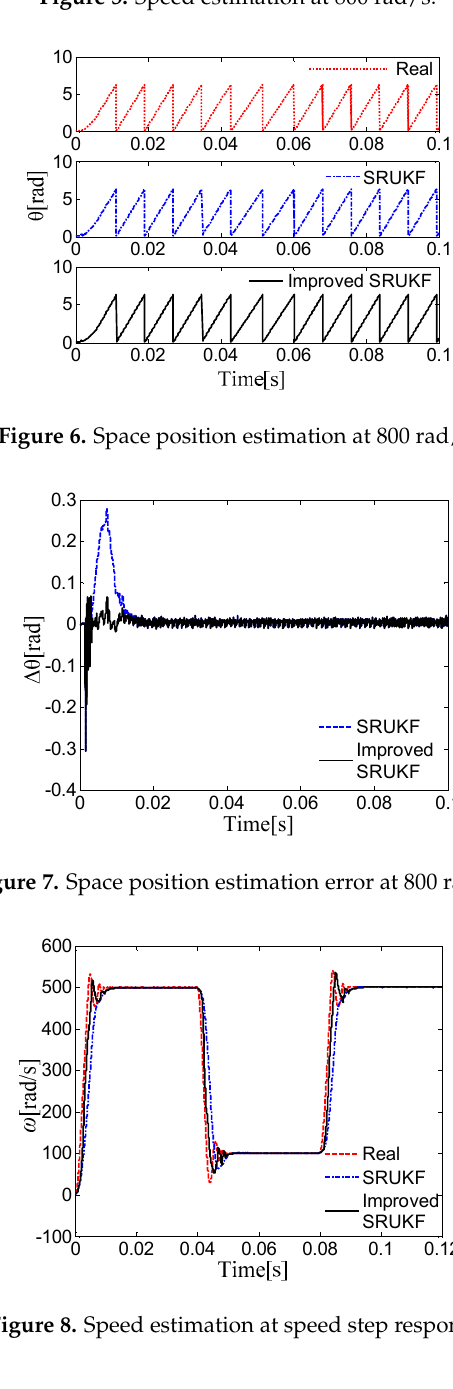
Figure 9. Space position estimation at speed step response.